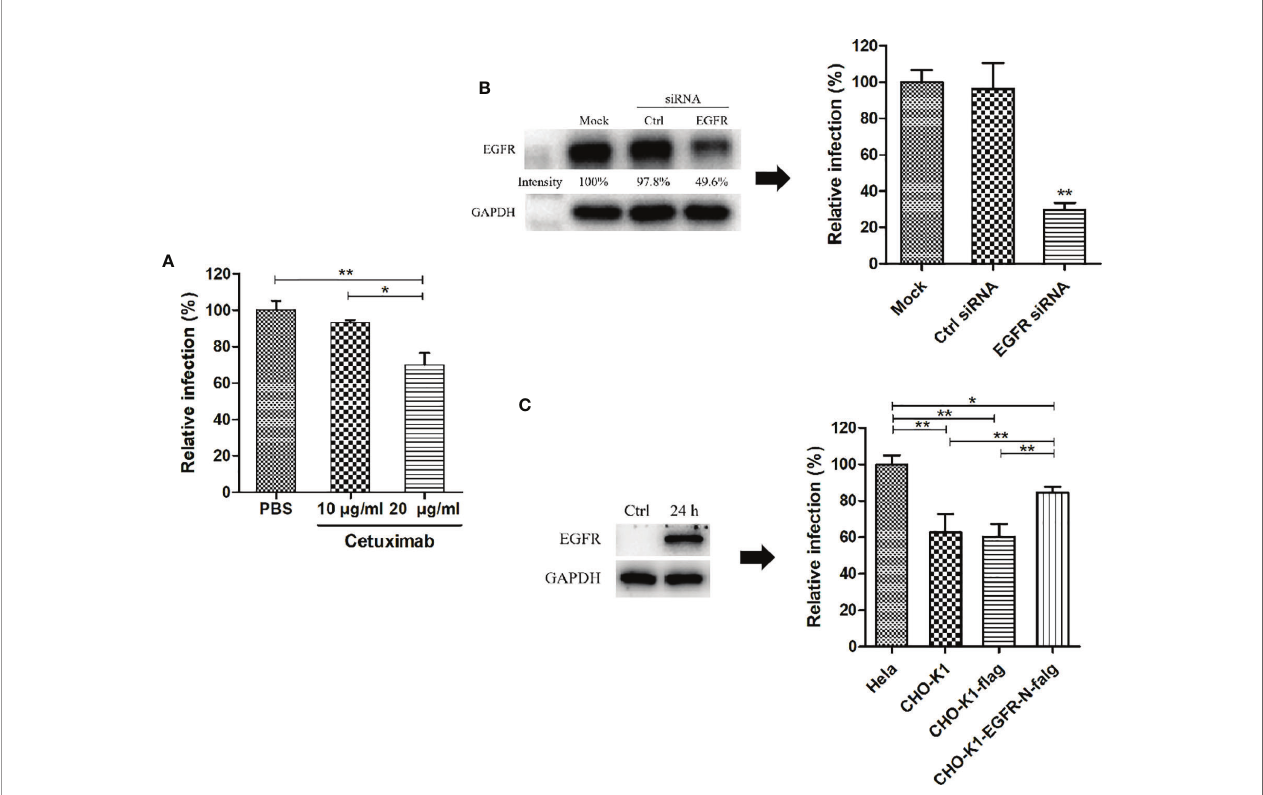
FIGURE 4 | EGFR was essential for C. psittaci infection. (A) HeLa 229 cells were treated with cetuximab (10 m g/ml and 20 m g/ml) for 2 h and then inoculated with C. psittaci 6BC (MOI=5). Relative infection was calculated on the basis of inclusion bodies, and Relative infection (%)=(IFUs of the treated group/IFUs of the control group) ×100. (B) HeLa cells were transfected with EGFR siRNA (siEGFR) or control siRNA (Ctrl). Twenty-four hours after the 2nd treatment with siRNA, the cell cultures were exposed to C psittaci 6BC (MOI=5) and, concurrently lysed to determine ef fi ciency of siRNA by Western blots. The intensity of the bands was quanti fi ed using ImageJ. GAPDH was used as the loading group. Intensity was determined as follows: Intensity(%)=(EGFR/GAPDH) ×100. In addition, inclusion bodies were counted and relative infection was determined as follows: Relative infection (%)=(IFUs of the siRNA-treated group/IFUs of the mock group) ×100. (C) CHO-K1 cells were